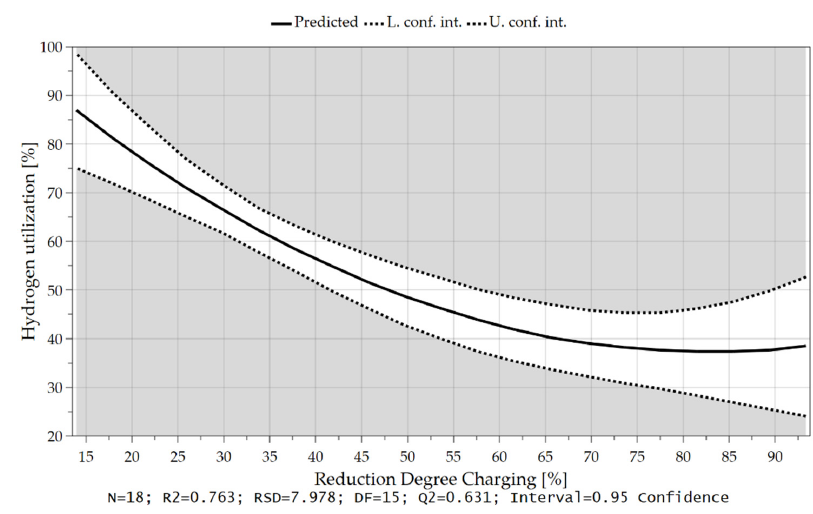
Figure 15. Average hydrogen utilization as a function of the H 2 content during iron ore charging.